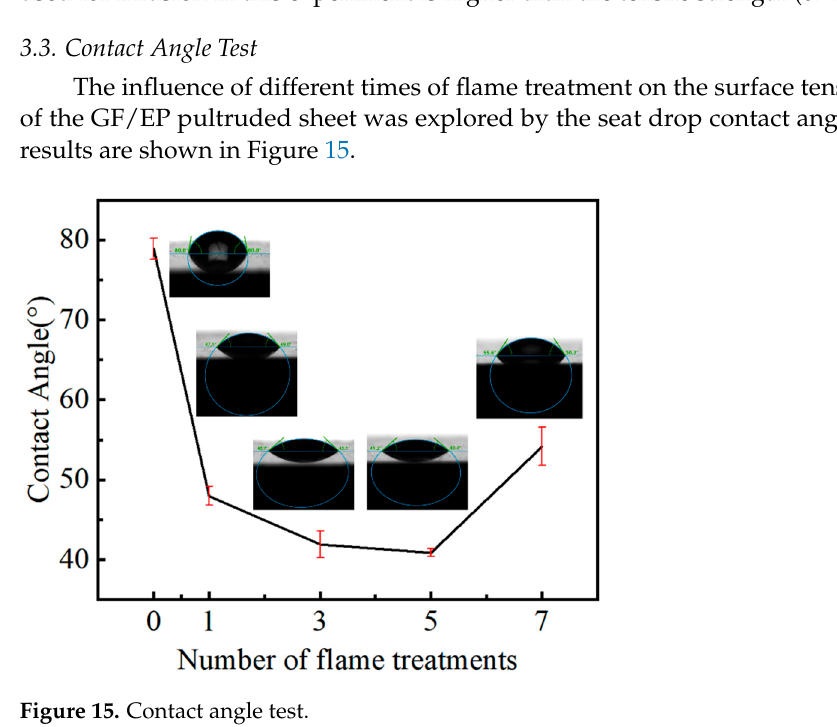
Figure 14. Schematic diagram of the whole process of flame treatment, infusion, and experimental loading on the surface of the GF/EP pultrusion sheet.